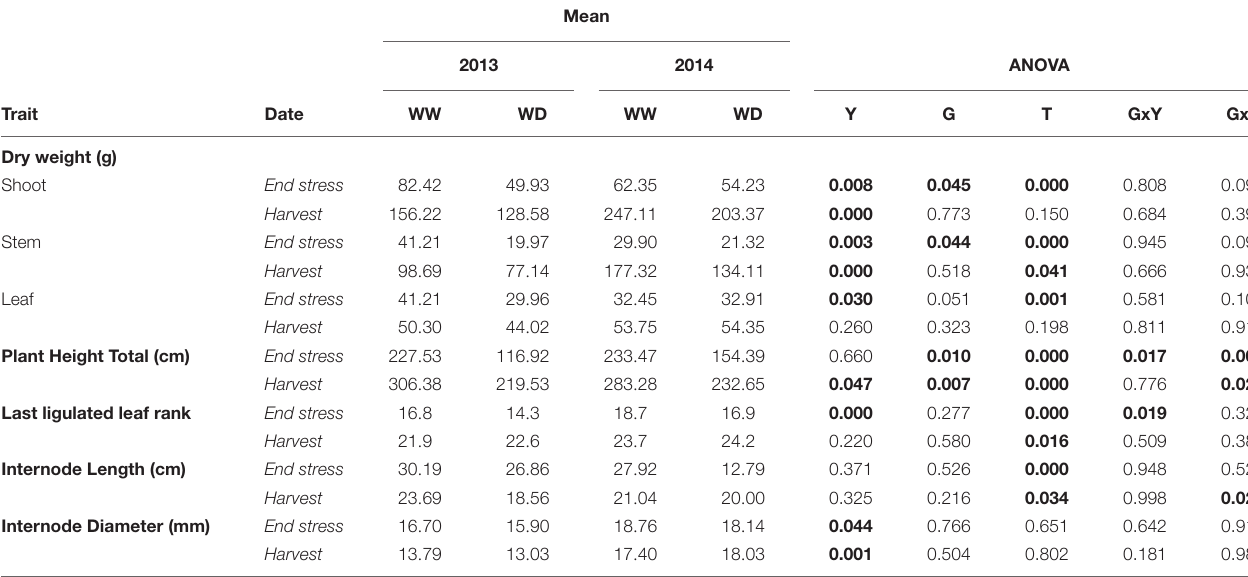
TABLE 2 | Mean values and corresponding ANOVA results for morphological variables (24 plants per block and stage) measured at two stages (end of the water deficit period and final harvest), for two hybrids G (G1: Biomass140, G4: RE1xAR4), 2 years Y (2013, 2014) and two water treatments T (well-watered: WW and 1-month water deficit during stem elongation: WD).